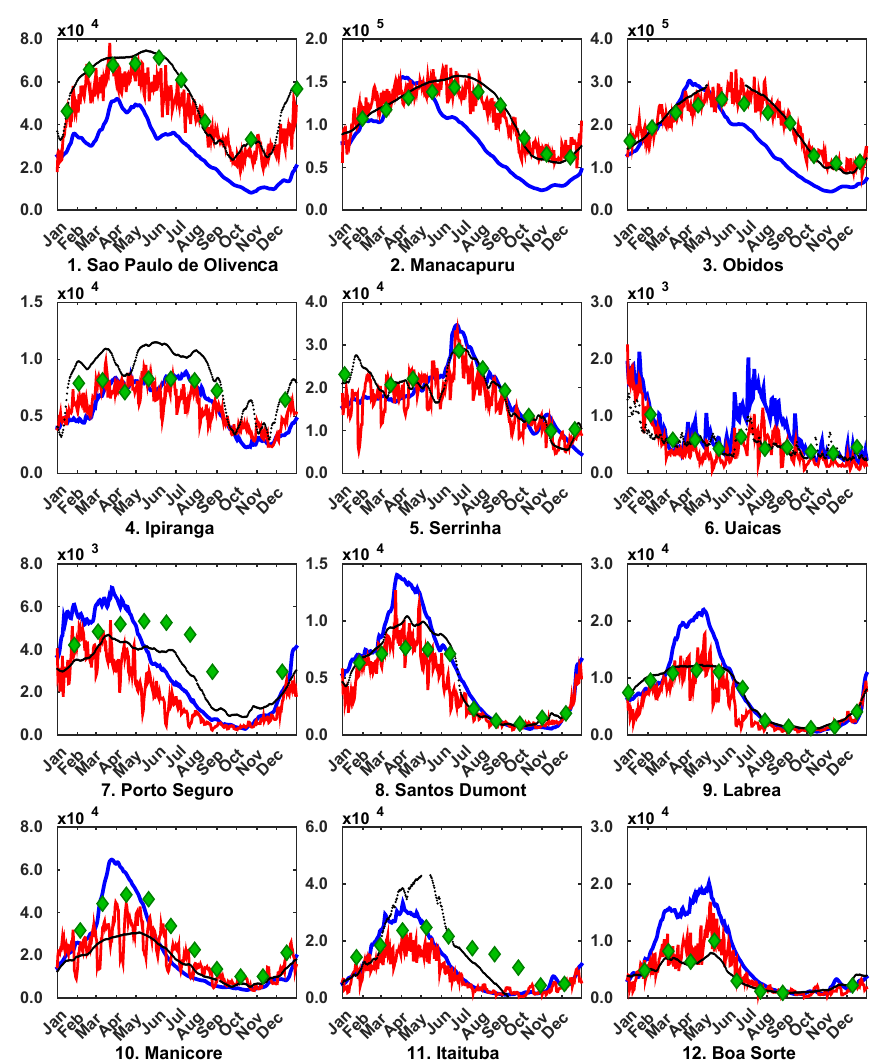
Figure 8. SE1-direct ensemble mean analysis discharge (red line) compared to the free run discharge (blue line), the ENVISAT observed discharges (green markers) and the measured gauge discharges (black dots) over the year 2009. For each panel, the x -axis represents time (in days) and the y -axis represents discharge (in m 3 s − 1